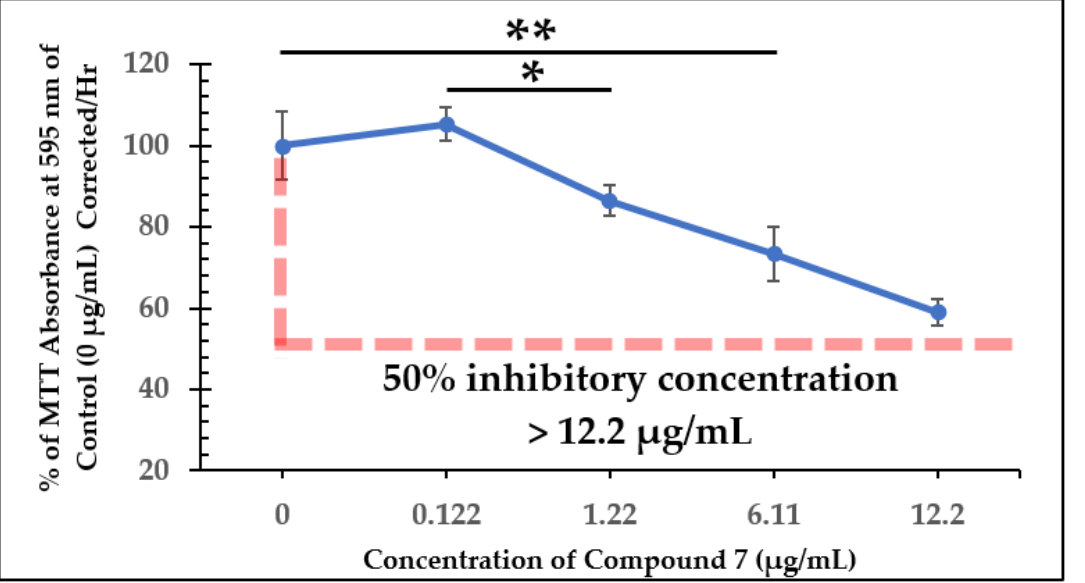
Figure 7. Dose-Dependent Effect of Compound 7 on L. tarentolae Immediately Following Addition (94 h). Values are the mean and standard deviation for n = 4 replicates. * denotes p < 0.05 between 0.122 µg/mL and 1.22 µg/mL of compound 7 . ** denotes p < 0.05 between 0 µg/mL and 6.11 µg/mL of compound 7 .